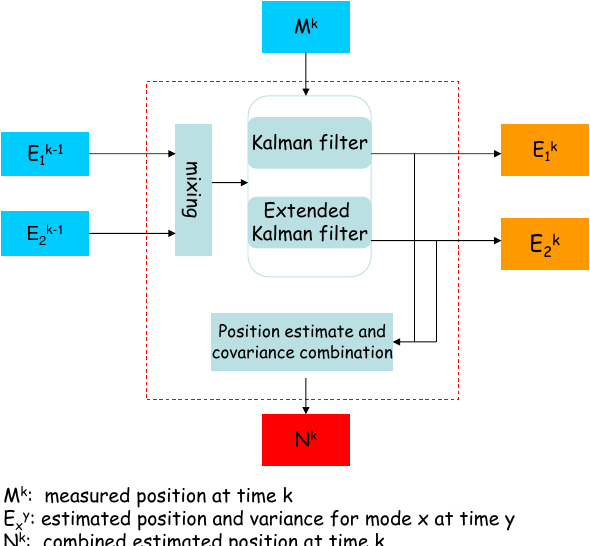
Figure 1. Block diagram of the tracking